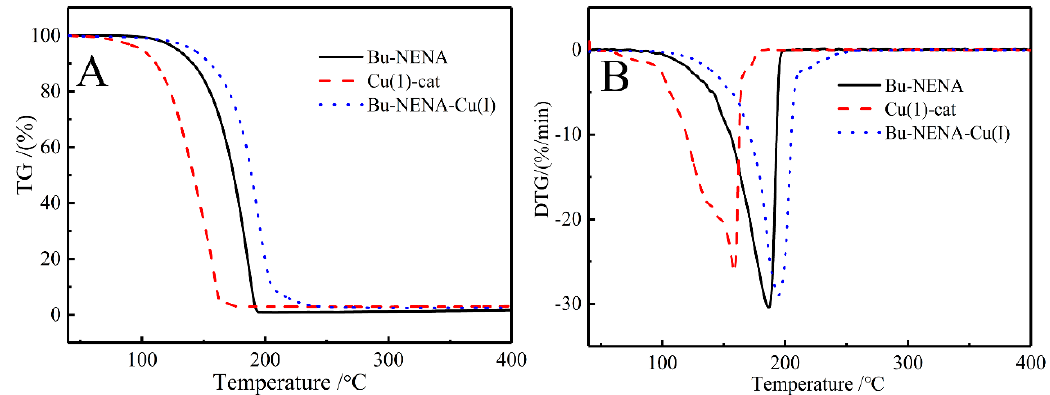
Figure 9. TG ( A ) and derivative thermogravimetric analysis (DTG) ( B ) curves of Bu-NENA and catalyst.